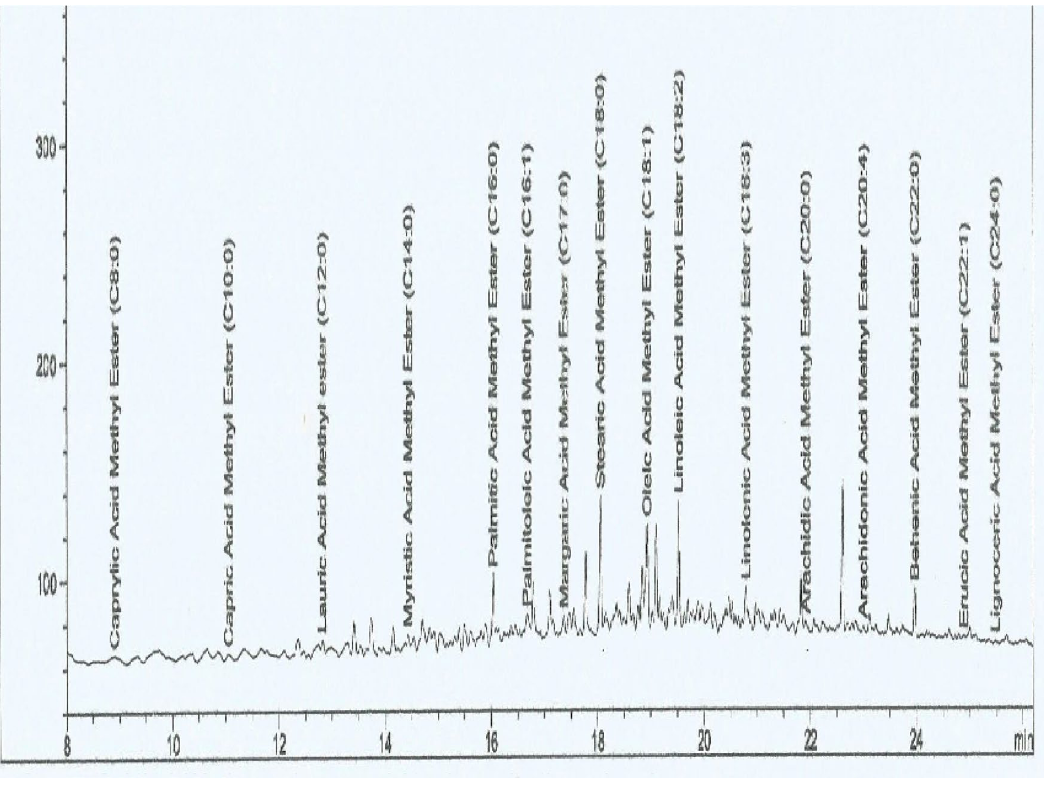
Figure 2. GC-FID chromatogram of C.schweinfurthii pulp